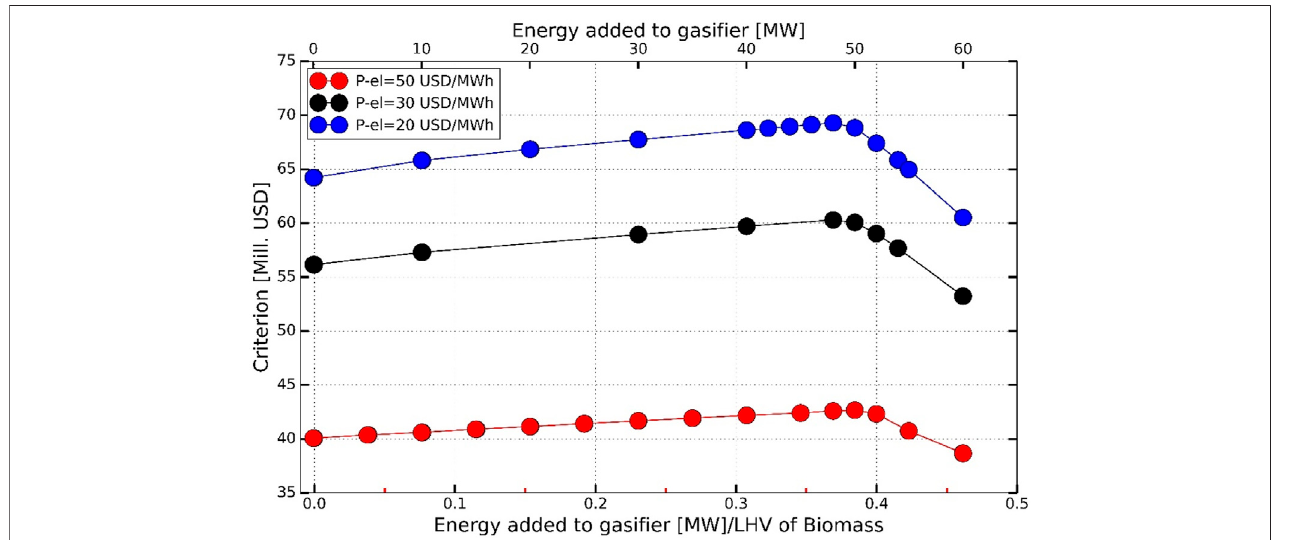
FIGURE 11 | Effect of cheaper electricity prices on criterion and optimal energy addition to gasi fi er.